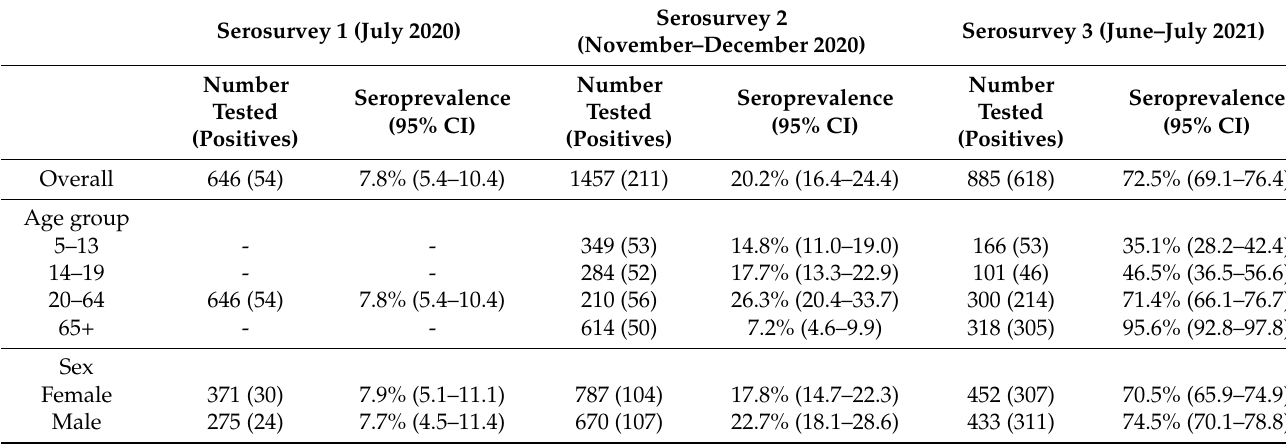
Table 1. Seroprevalence estimates through the COVID-19 pandemic waves in southern Switzerland.